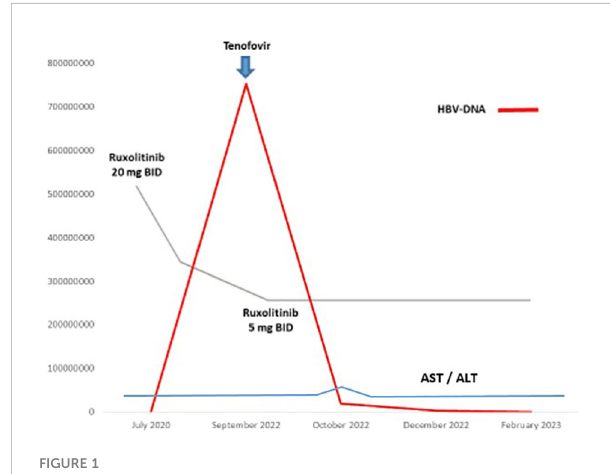
FIGURE 1 HBV-DNA levels during treatment (UI/ml, red